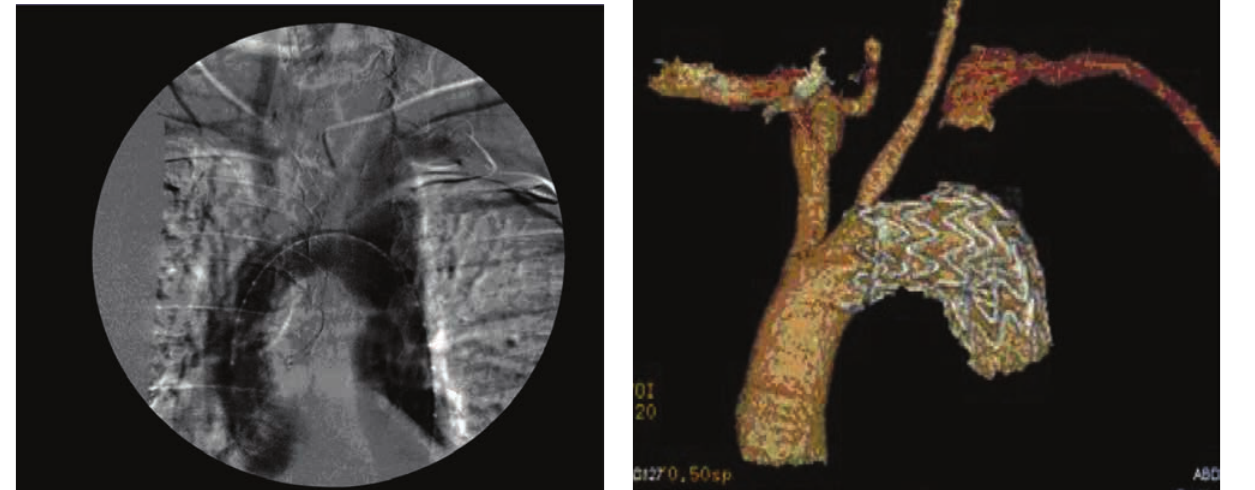
Figure 4: Follow-up angio-CT performed 30 months after stent-graft